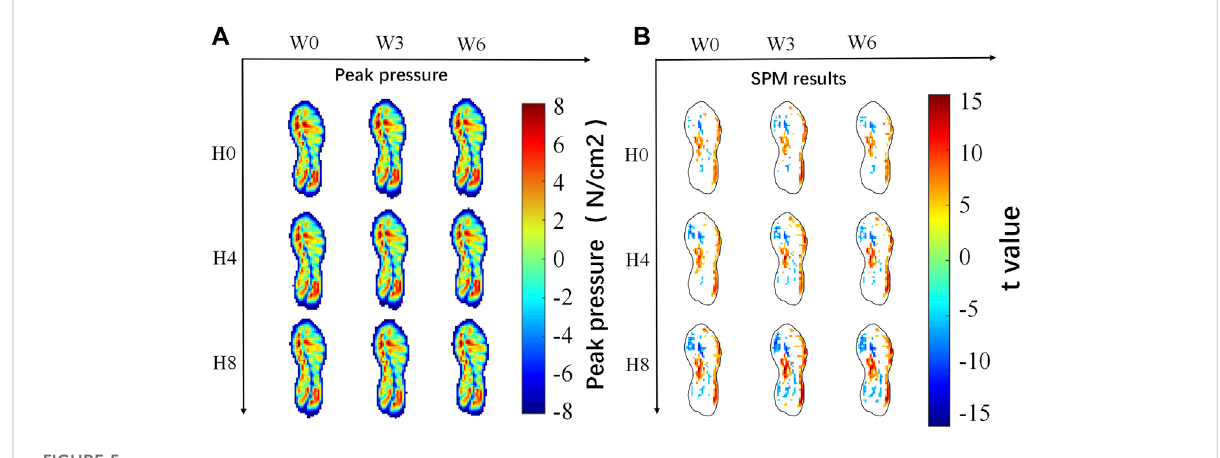
FIGURE 5 Results of plantar pressure analysis of 9 pairs of different arch